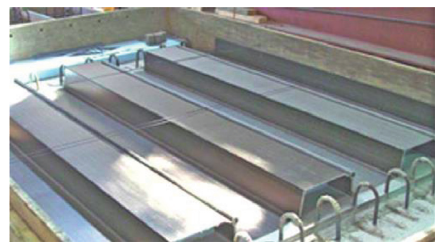
Figure 8: Top view of SIP form proposed by Fam.